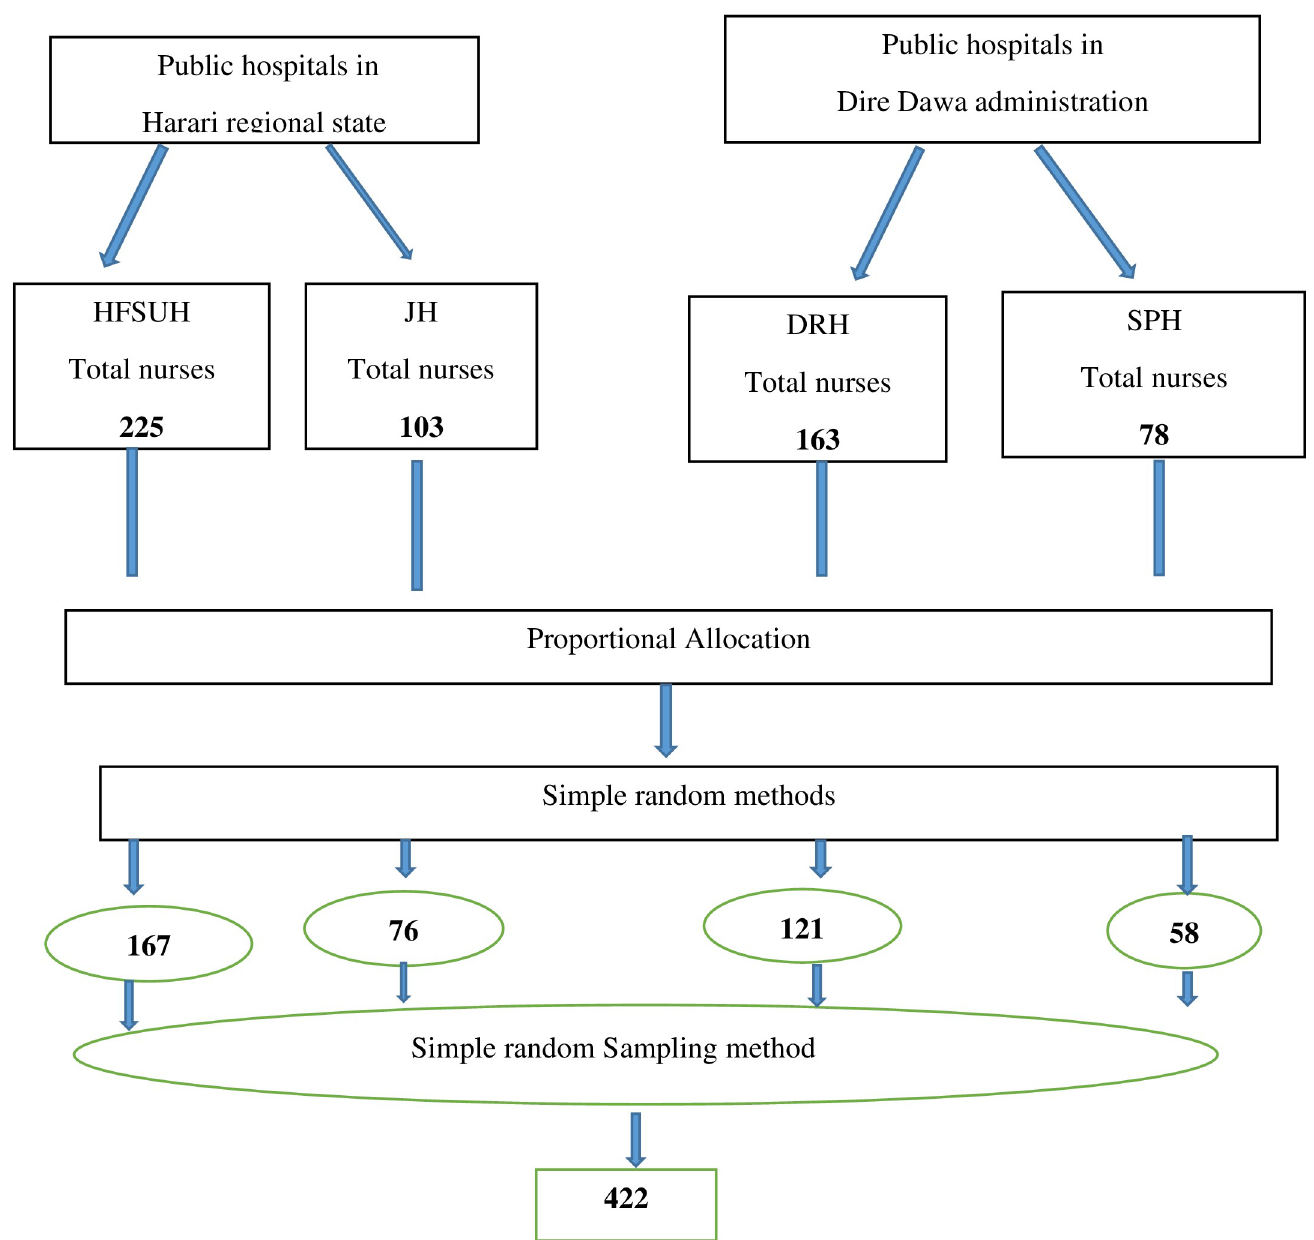
Fig 1. The schematic presentation of the sampling procedure for the study on the magnitude of burnout and associated factors among nurses working in Harari regional state and Dire Dawa city administration, 2020.